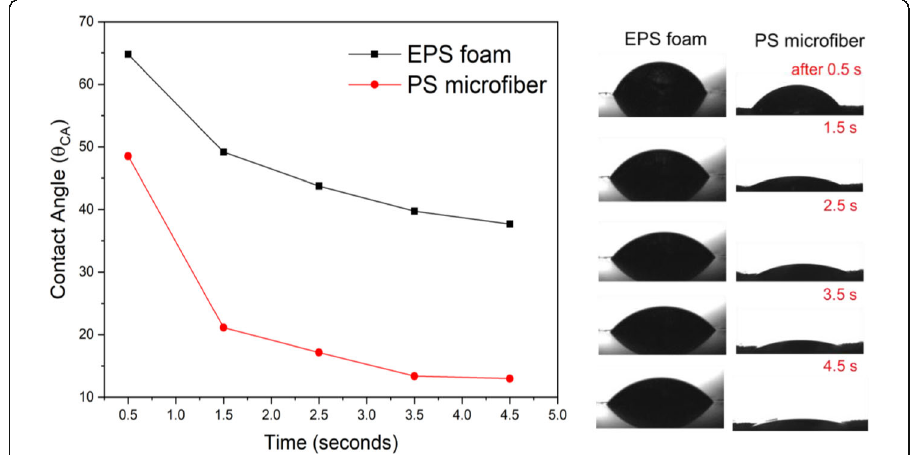
Fig. 6 Wettability profile and contact angle images of oil in EPS foam and PS microfibers through